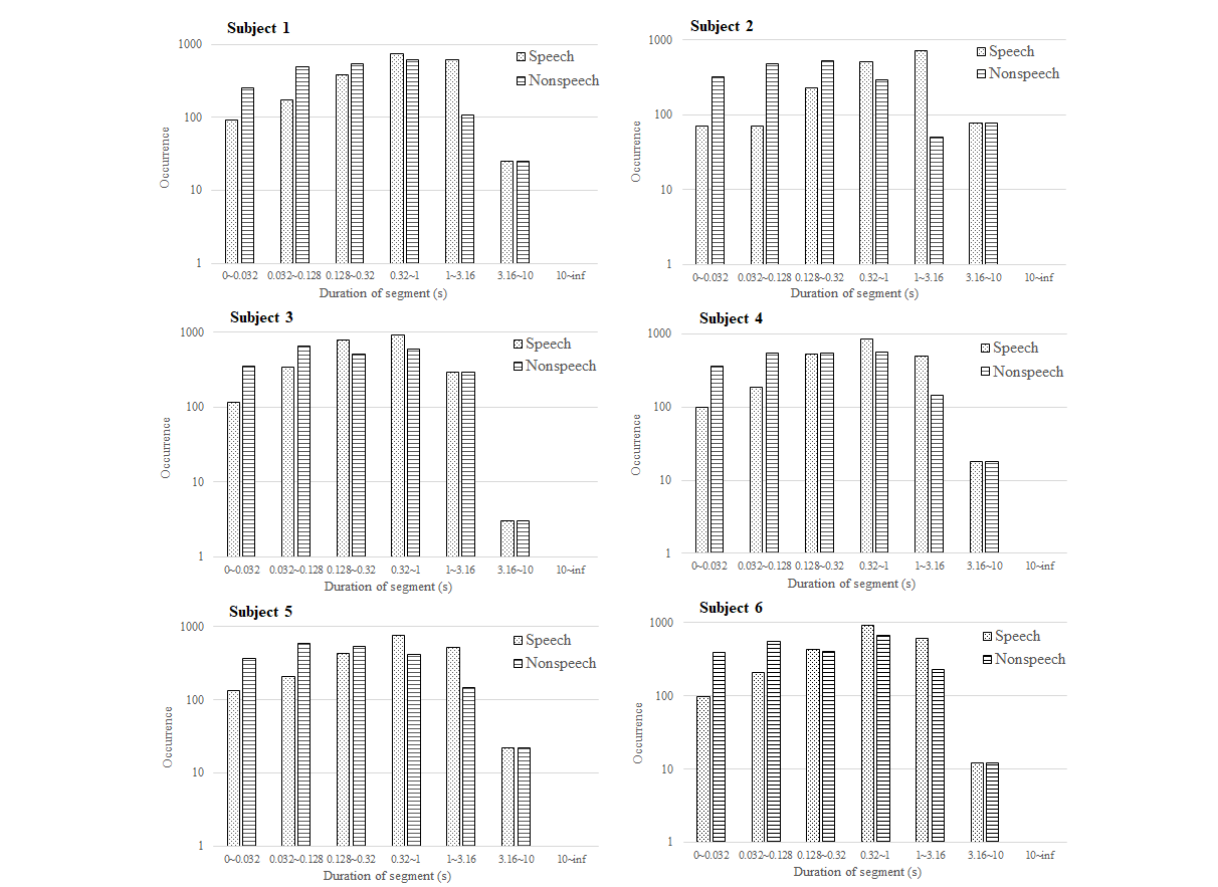
Figure 6. Speech and nonspeech segments measured by the automatic speech detection system. The x-axis indicates the length of the speech segments in a logarithmic scale, while the y-axis represents the occurrences during the recording period in a logarithmic scale (Subjects 1-6).